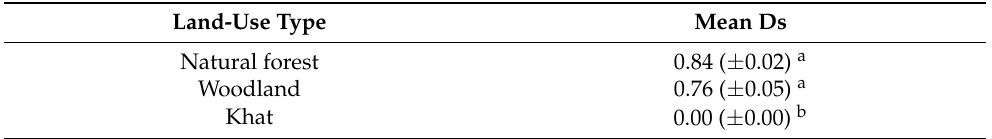
Table 3. Mean ( ± standard error) of Ds of woody plants in three land-use types. Mean values followed by the same letter did not differ significantly (Tukey HSD test, p > 0.05).